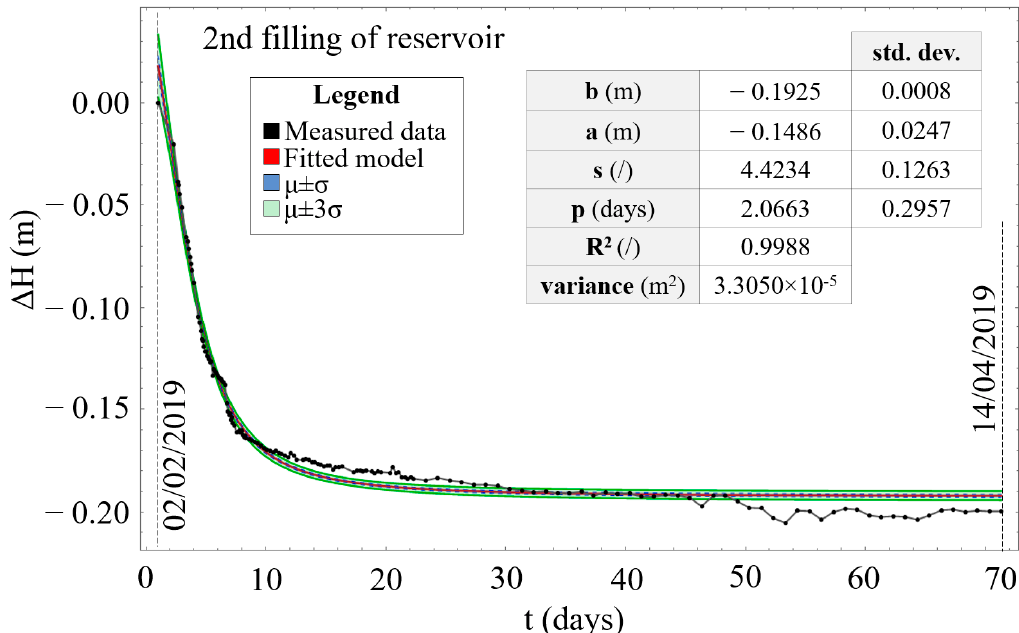
Figure 19. Fitted model for point MG19, based on obtained data from 02 / 02 / 2019 to 14 / 04 / 2019; actual data (black), best fitted FNSE model (red), µ ± σ confidence interval (blue) and µ ± 3 σ confidence interval (green).